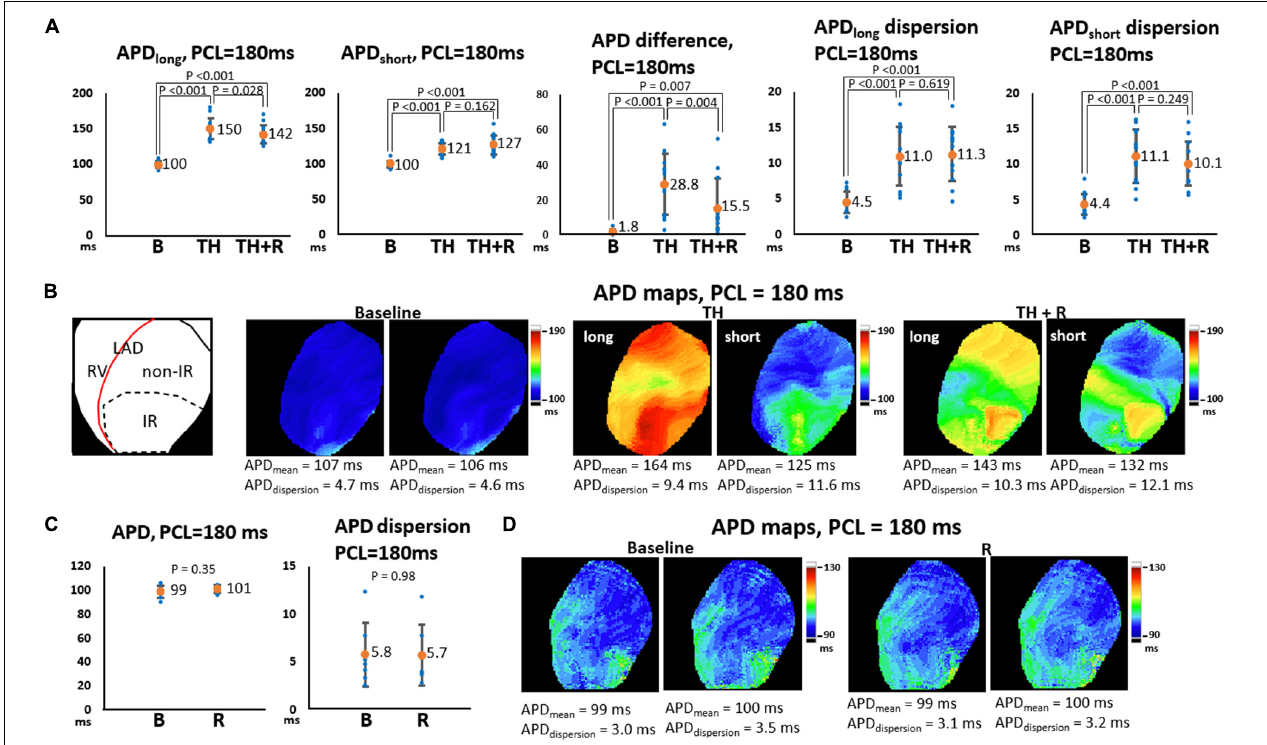
FIGURE 3 | Effects of therapeutic hypothermia (TH) and rotigaptide (R) on action potential duration (APD) and APD dispersion (APD dispersion ) at a pacing cycle length (PCL) of 180 ms. (A,C) Summarized results of APD, APD difference, and APD dispersion in the TH ( n = 14, repeated-measures ANOVA with post hoc LSD analysis) and non-TH groups ( n = 7, Student’s t -test), respectively. Numbers indicate the mean values of APD (APD mean ). Beat-to-beat APD variability was noted at shorter PCLs during TH. TH prolonged APD and increased APD difference and APD dispersion significantly. Rotigaptide shortened the longer APD but did not change the shorter APD significantly, resulting in a decrease in APD difference between the consecutive beats. (B,D) Representative APD 80 and APD dispersion maps in the TH and non-TH groups, respectively. IR, ischemia–reperfusion; LAD, left anterior descending artery; RV, right